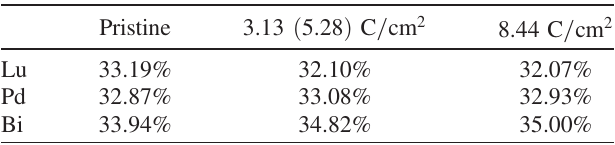
ratios of each constituent element in the pristine, 3.13 (and then irradiated to 5 . 28 C = cm 2 ), and 8 . 44 C = cm 2 (and then irradiated to 11 : 61 C = cm 2 ) irradiated crystals, obtained by the EDX measurements.